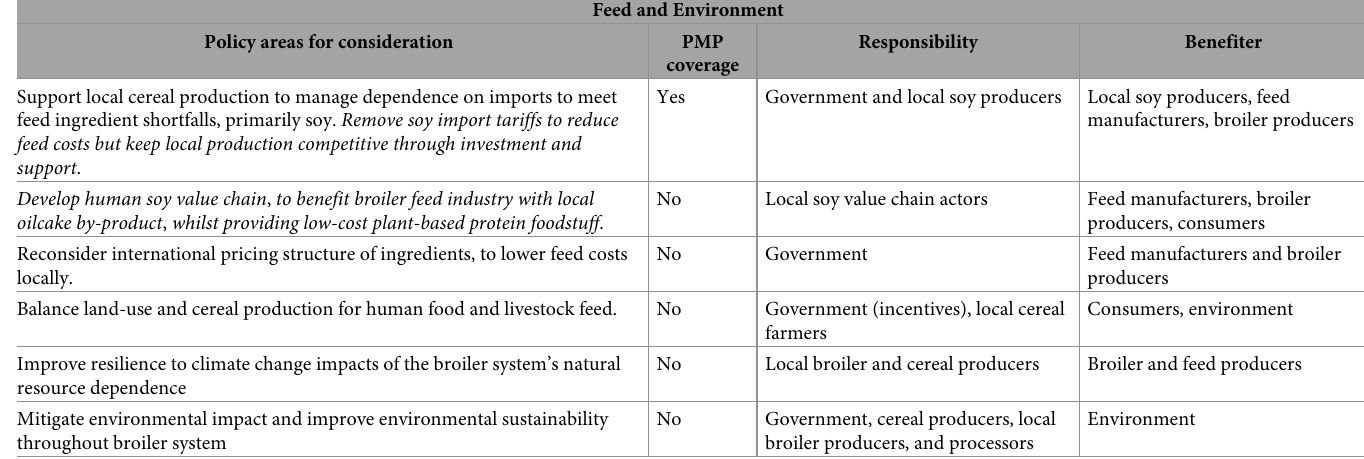
Table 3. Summary of feed and environment policy areas for consideration. Original ideas presented in meetings are in plain font, and stakeholder additions in italics (PMP = Poultry Master